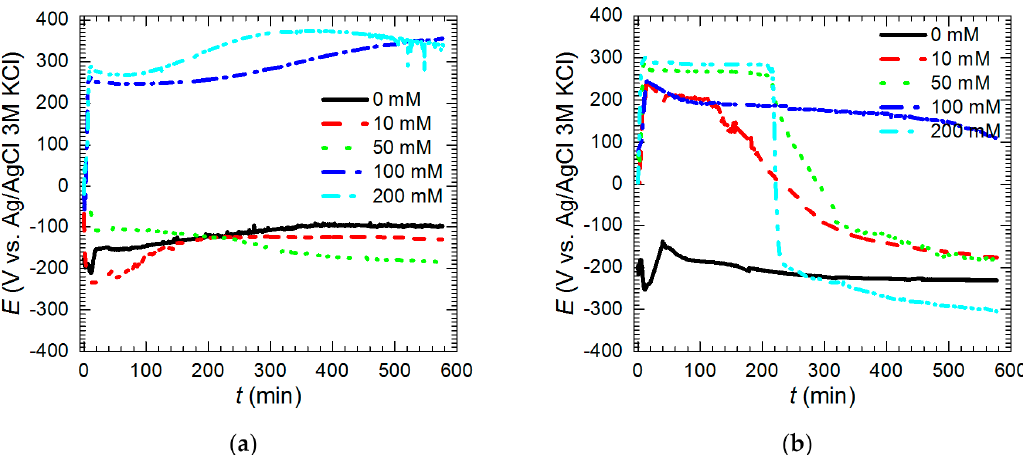
Figure 9. Open-circuit potential of intermetallic Al 2 Cu as a function of time and initial concentration of Na 3 VO 4 in the solutions: ( a ) pH = 1.3; ( b ) pH = 2.5, T = 303 K.